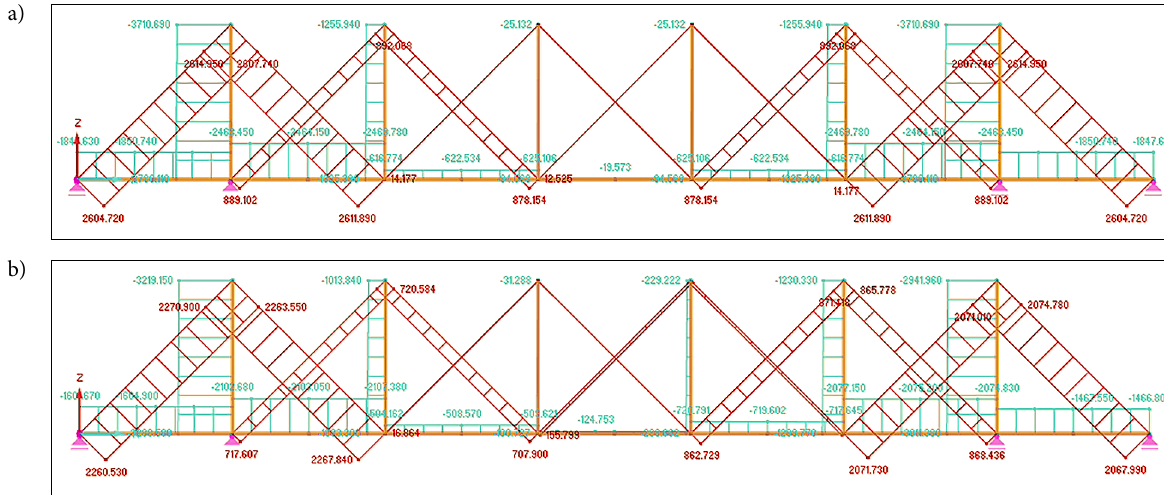
Figure 3. Equal pylons bridge. Axial forces: a) under symmetrical loading; b) under asymmetrical loading